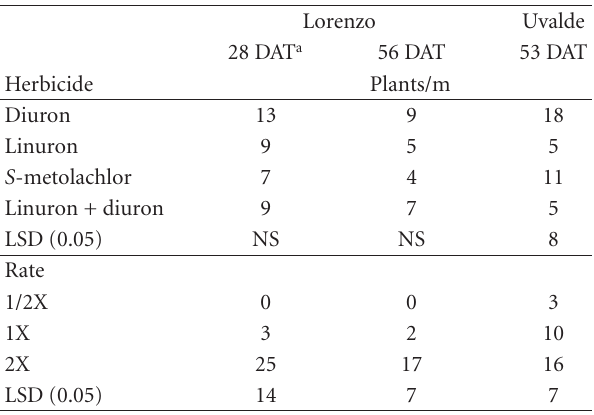
Table 4: Sesame stunting as influenced by preemergence herbicides and herbicide rate at Lorenzo in 2008 and Uvalde in 2007.